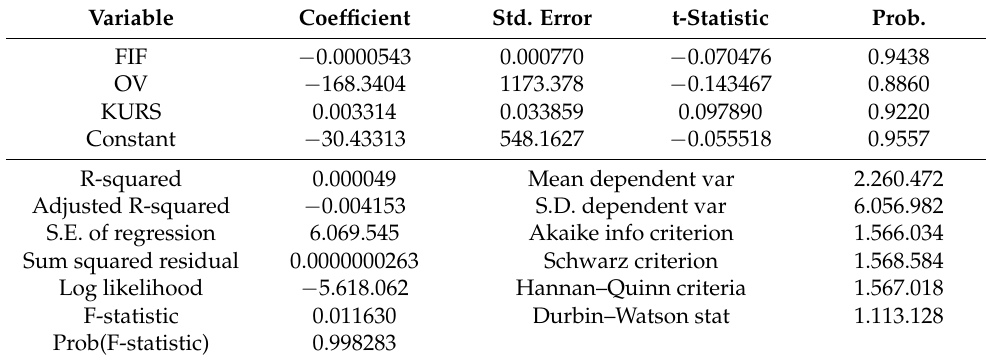
Table 12. Panel Data